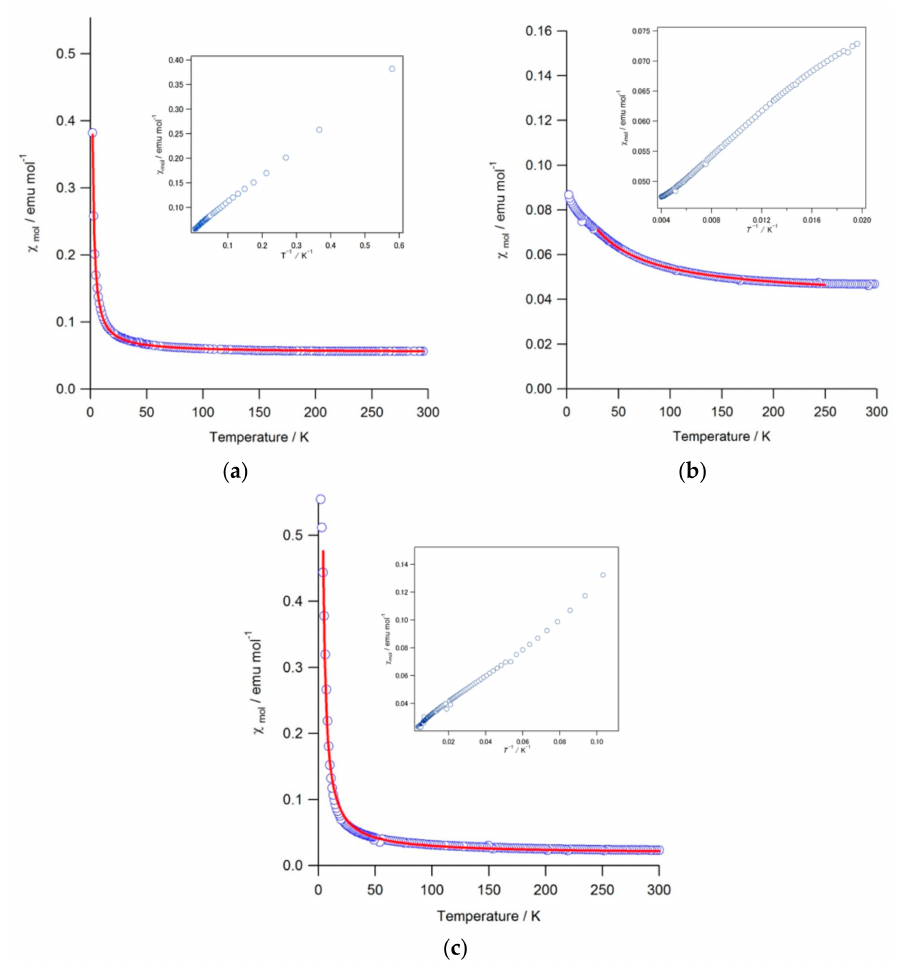
Figure 5. Temperature dependence of the magnetic susceptibility of ( a ) Ce 0.99 Co 4 Sb 9.65 Ge 2.51 ; ( b ) Pr 0.97 Co 4 Sb 9.52 Ge 2.61 ; and ( c ) Nd 0.87 Co 4 Sb 9.94 Ge 2.28